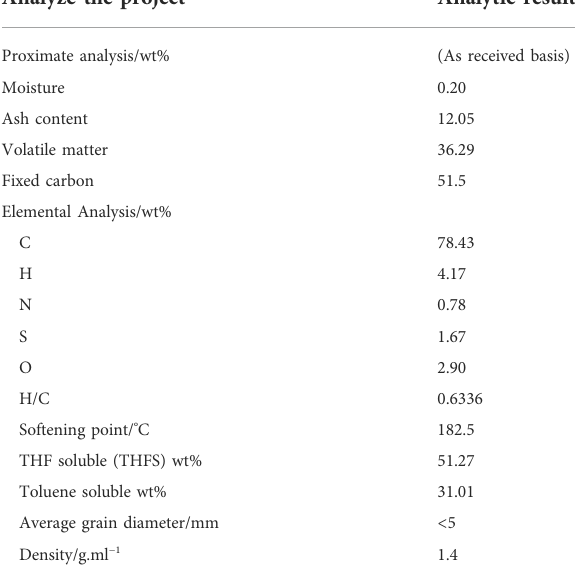
TABLE 1 Analysis results of coal liquefaction residue